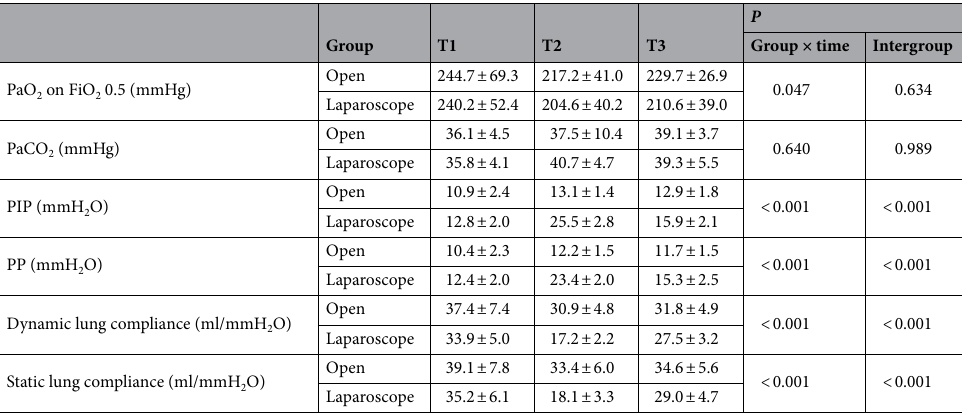
Table 2. Pulmonary variables during the operation. Data are expressed as mean ± standard deviation. T1 = after intubation, T2 = 90 min after the incision, T3 = at the end of the operation with recovery of muscle relaxation under mechanical ventilation, FiO 2 = fraction of inspired oxygen, PIP = peak inspiratory pressure, PP = plateau pressure. PIP, PP, dynamic and static lung compliance measured by an anaesthesia machine (Primus Ⓡ , Dragger, Lubeck, Germany).